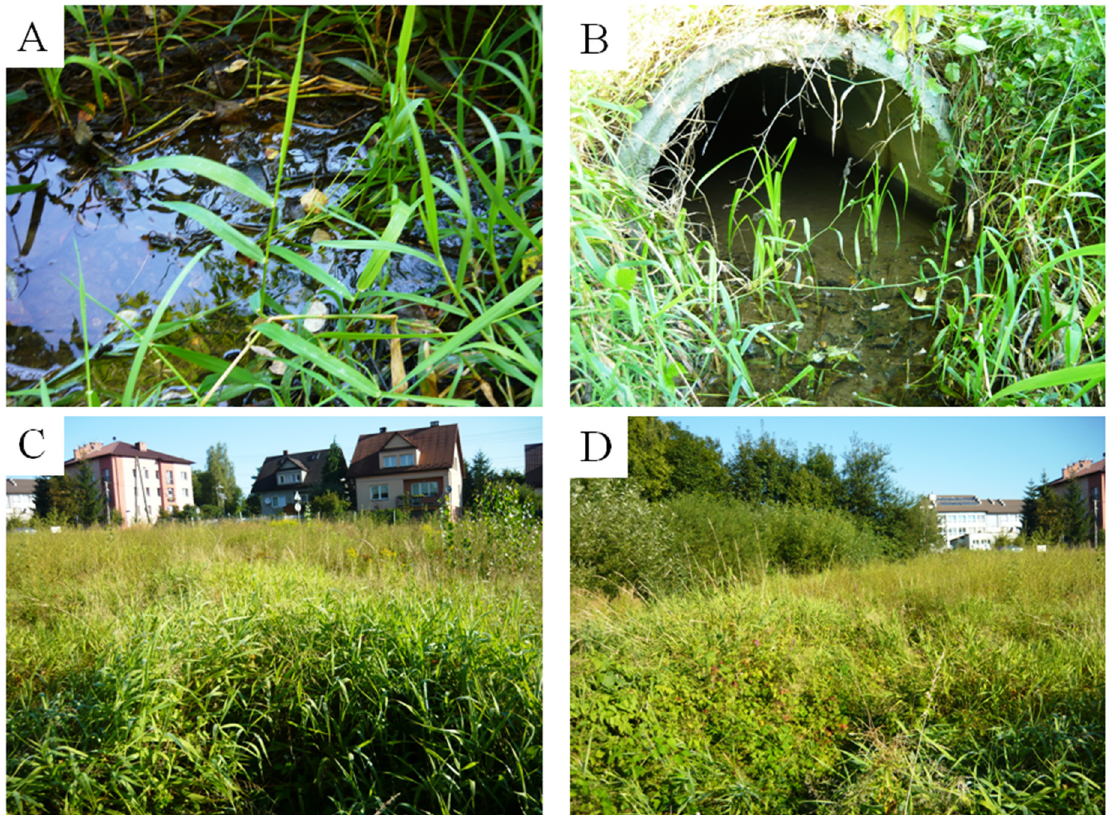
Figure 6. Selected elements of the hydromorphological diversity index in the urbanised section: ( A )—overgrown bed with laminar flow; ( B )—outlet of Ø 1.00 m concrete culvert; ( C )—grass veg- etation (wasteland) and built-up areas; ( D )—trees and shrubs. Grass vegetation (wasteland).